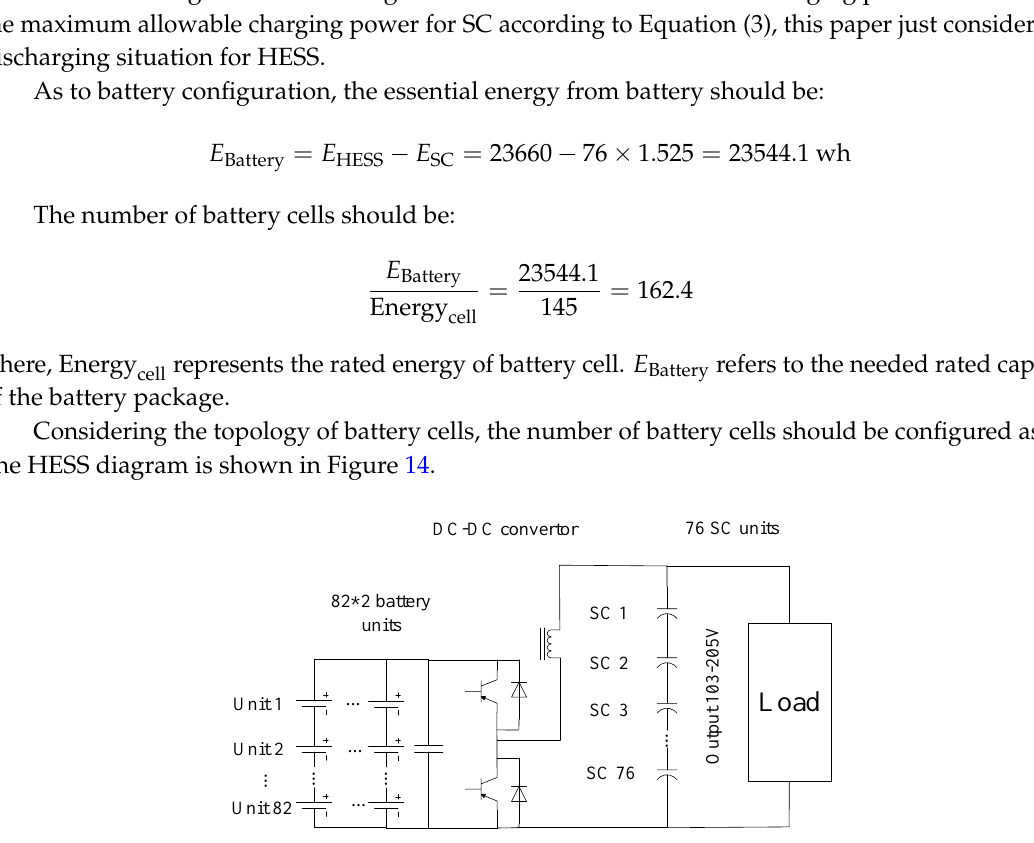
Table 6. Component configuration.